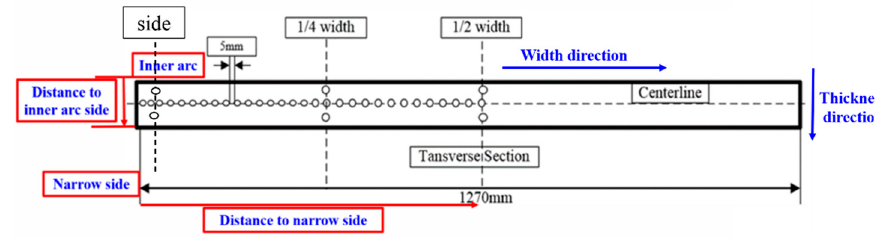
Figure 4. Testing position for OES.